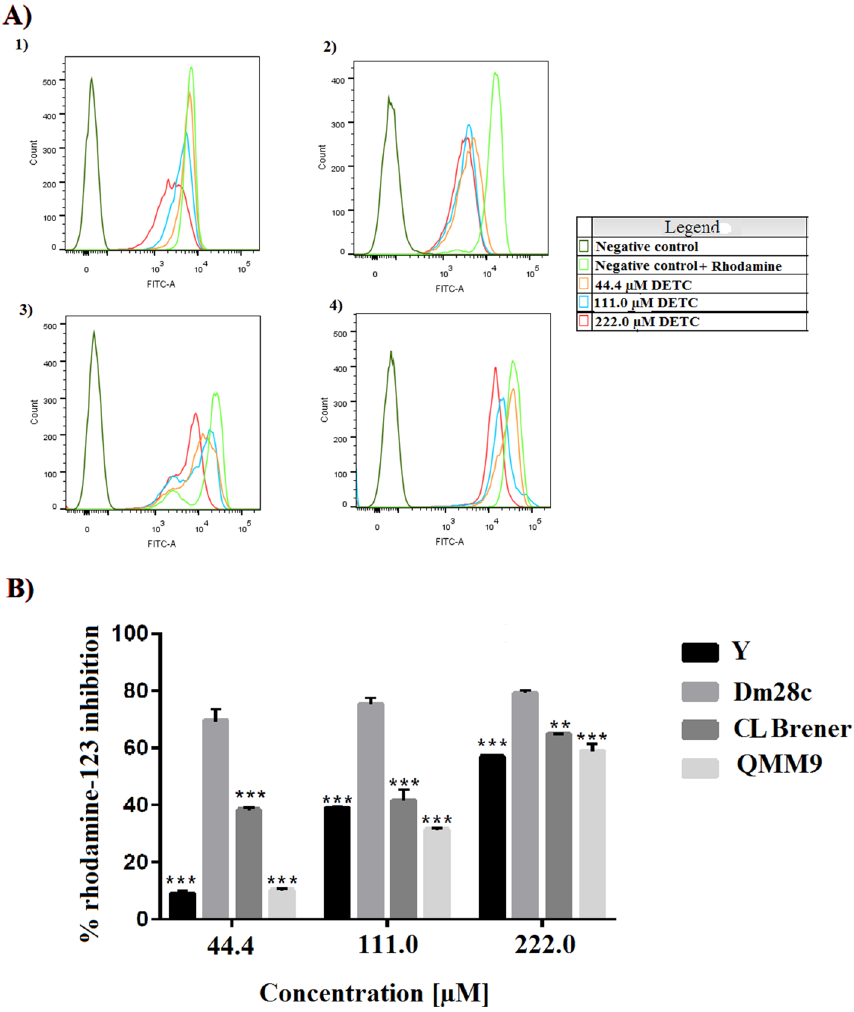
Figure 5. Evaluation of the mechanism of mitochondrial damage caused by DETC in Trypanosoma cruzi . (A) Fluorescence intensity (rhodamine-123) in different strains in trypomastigote form of T. cruzi untreated (control), represents 100% of fluorescence, and treated with different concentrations of DETC (44.4 µM, 111.0 µM, 222.0 µM) for 24 h. (1) Y strain; (2) Dm28c strain; (3) CL Brener strain; (4) Qmm9 strain. 10,000 events were used for each analysis to obtain the data, which was carried out in triplicate. (B) Fluorescence intensity (%) of rhodamine-123 inhibition of different strains of T. cruzi treated with different concentrations of DETC. The results were presented based on mean ± standard deviation of the percentage of parasitic inhibition. The statistical analyses were performed using the Anova Test with the Tukey Post-test (P < 0.01 (**); P < 0.001 (***). The statistical analyses were used to compare the profile of each strain treated with the same DETC concentration. Flow cytometer (FACSCanto II, BD Biosciences, Eugene, OR, USA) with FACSDiva software, version 6.1.2 (Becton Dickson, Franklin Lakes, NJ, USA) (https:// www. bdbio scien ces. com/ en- us/ instr uments/ resea rch- instr uments/ resea rch- softw are/ flow- cytom etry- acqui sition/ facsd iva- softw are) and software GraphPad Prism v. 7.0 (2016) (https:// www. graph pad.